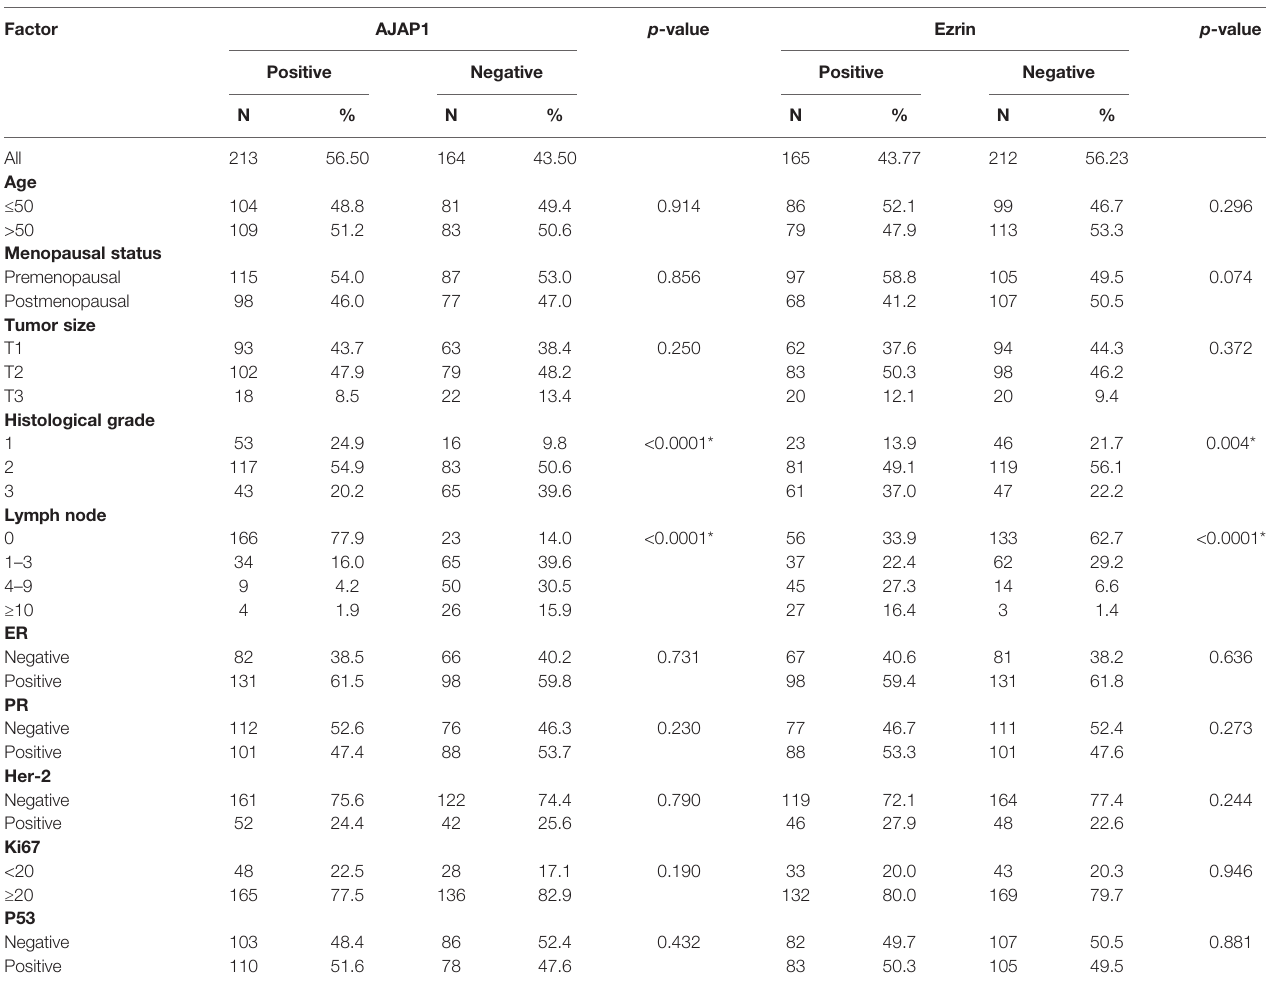
TABLE 1 | AJAP1 and Ezrin expression with clinicopathological parameters in breast cancer patients.